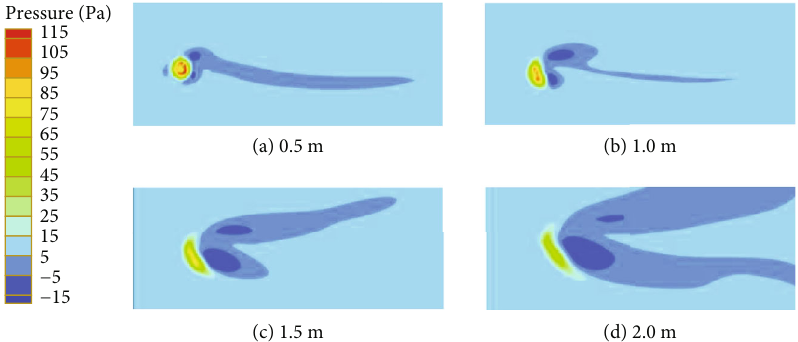
Figure 6: Pressure distribution below the rotor when free stream velocity is 3 m/s.